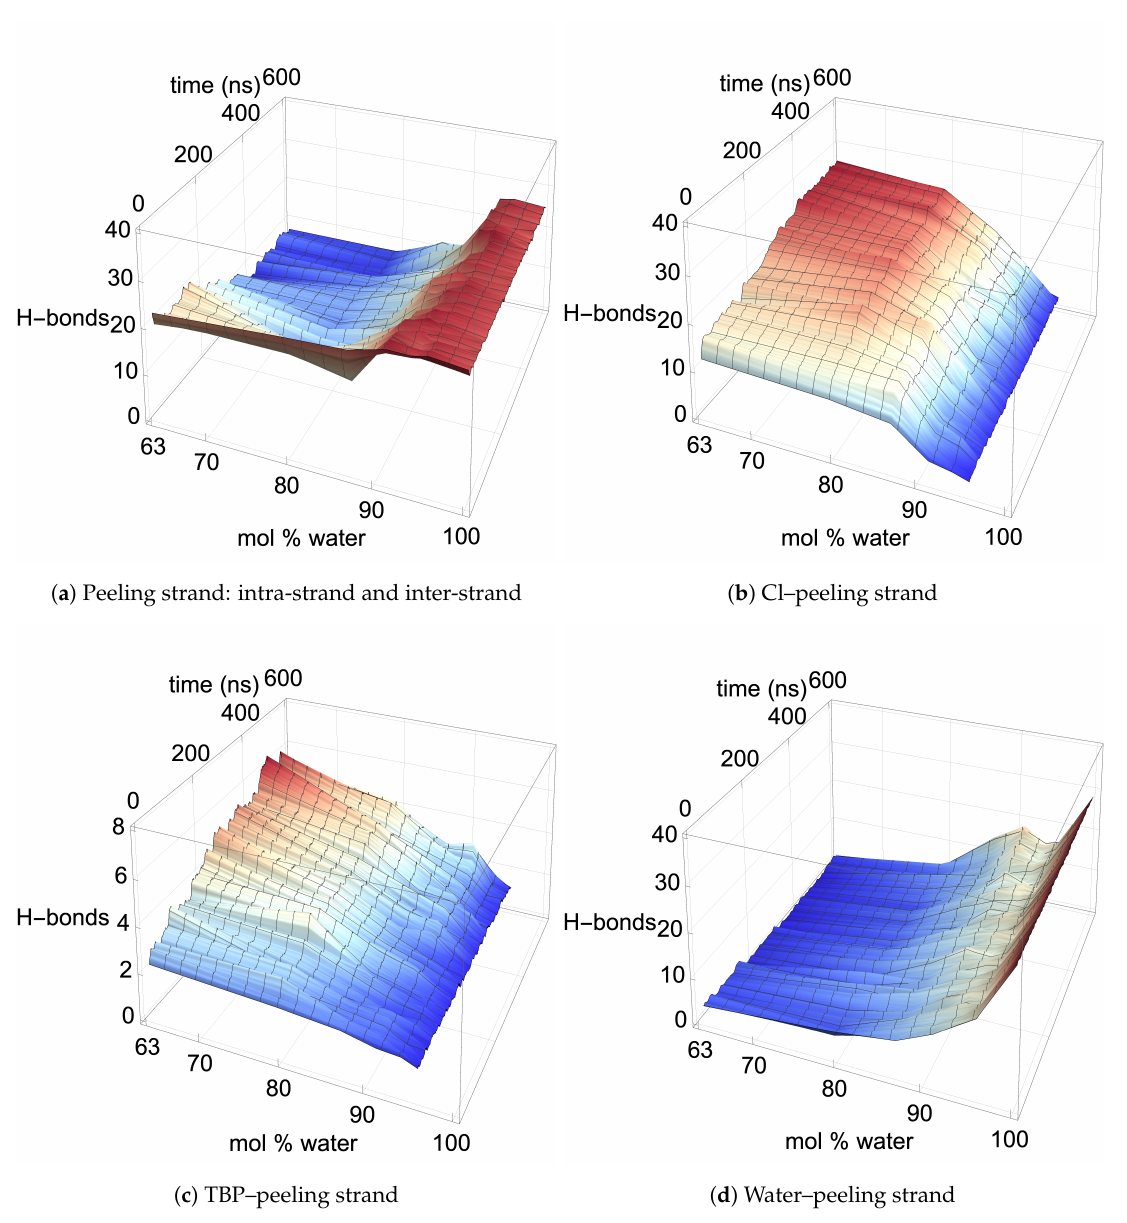
Figure 12. The hydrogen bonding for the first yellow separating strand at 360K (Part 1 of 2). The hydrogen bonds are shown between the following: ( a ) (bundle–peeling strand and peeling strand)–peeling strand (i.e., intra-strand and inter-strand hydrogen bonds for the separating strand); ( b ) Cl–peeling strand; ( c ) TBP–peeling strand; ( d ) water–peeling strand. These data represent the first yellow strand to peel or the non-peeling yellow strand if no yellow strands peeled in the simulation. The data were averaged over 1000 data points, using a rolling average. Every 100th point was then plotted to maintain plot clarity